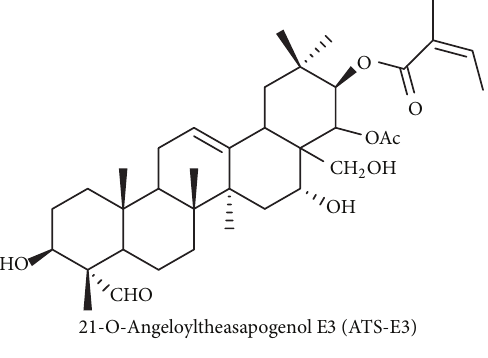
Figure 1: Chemical structure of